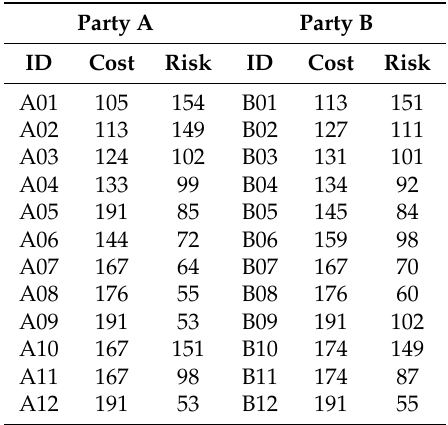
Figure 2. MapReduce-based multi-party secure skyline computation model. Table 2. Data of Party A and Party